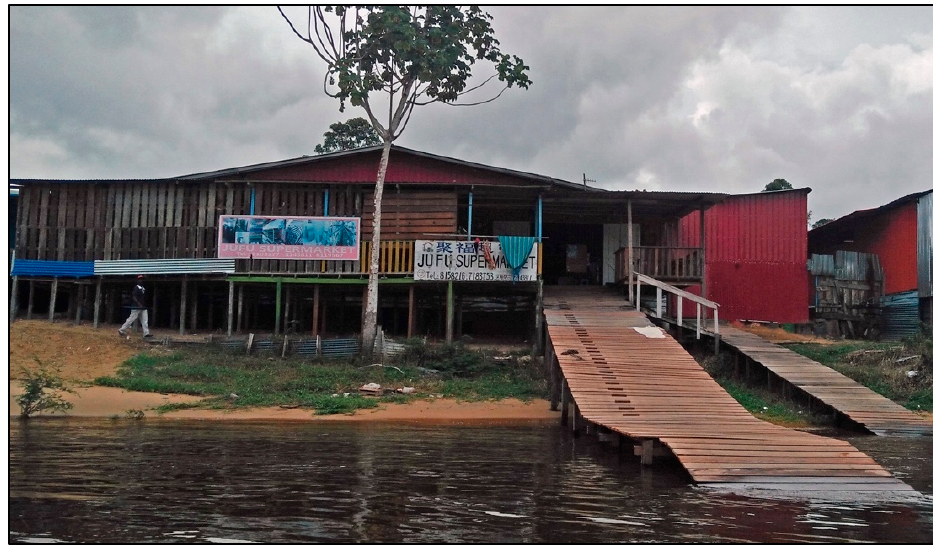
Figure 3. Chinese trade along the Maroni opposite Maripasoula (Source: Luc